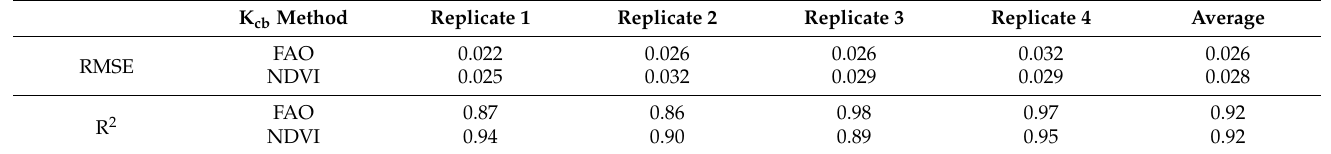
Table 7. Root Mean Squared Error (RMSE) and coefficient of determination (r 2 ) for simulated